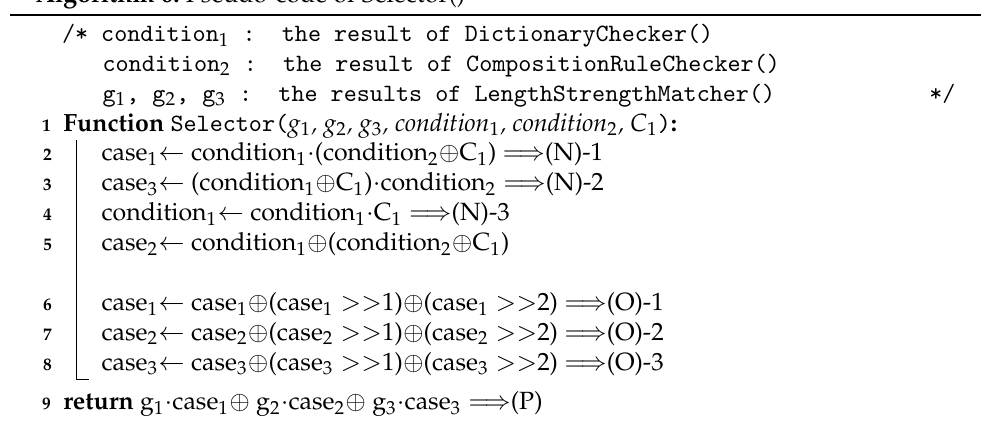
Algorithm 6: Pseudo-code of